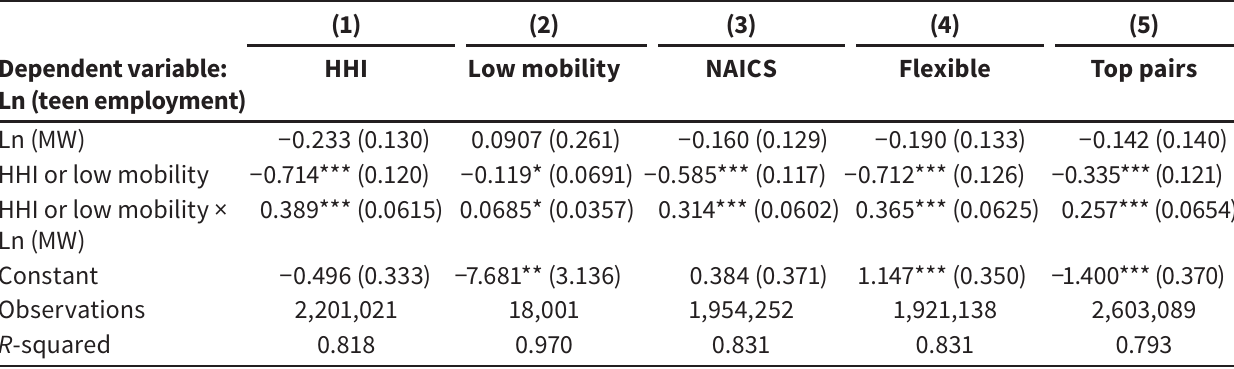
Effects of the log of the MW interacted with the HHI and low mobility on the log of teenage employment, allowing different effects of MW by